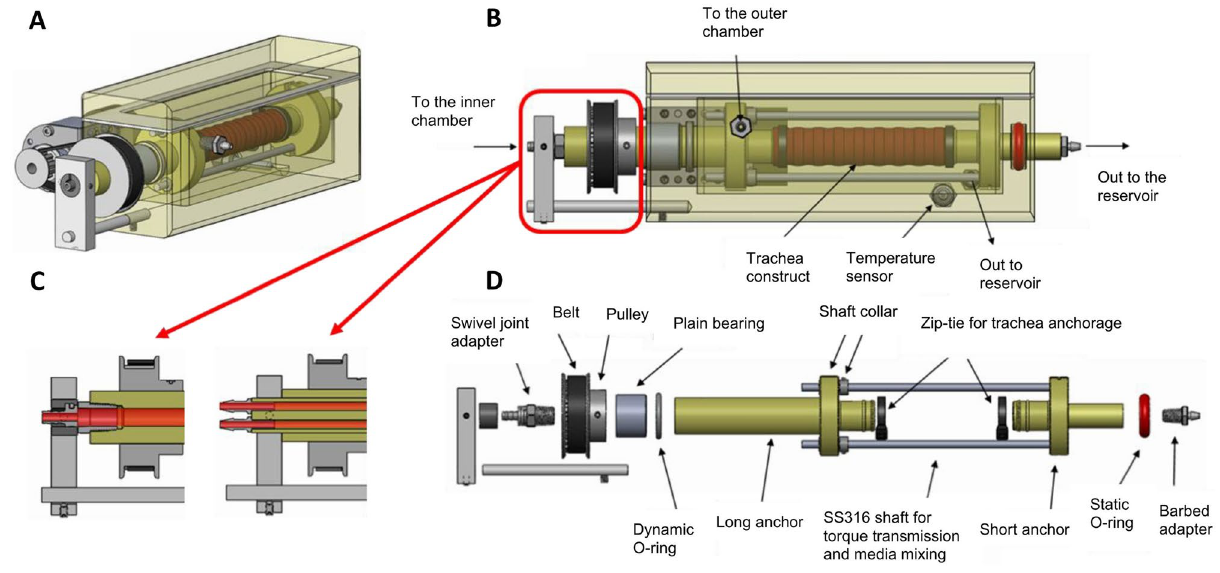
Figure 1. CAD model of the double-chamber tubular-scaffold bioreactor. The bioreactor body and lid are shown as translucent. ( A ) An isometric view of the bioreactor showing the motor, pulleys and belt which allows the tracheal rotation; ( B ) Side view of the trachea bioreactor; ( C ) Magnified cross-sectional view of two inlet designs; ( D ) Exploded view of the bioreactor components without the body and the lid. Figure was generated using Solidworks v2016 (Dassault Systemes, Vélizy-Villacoublay, France; https ://www.solid works